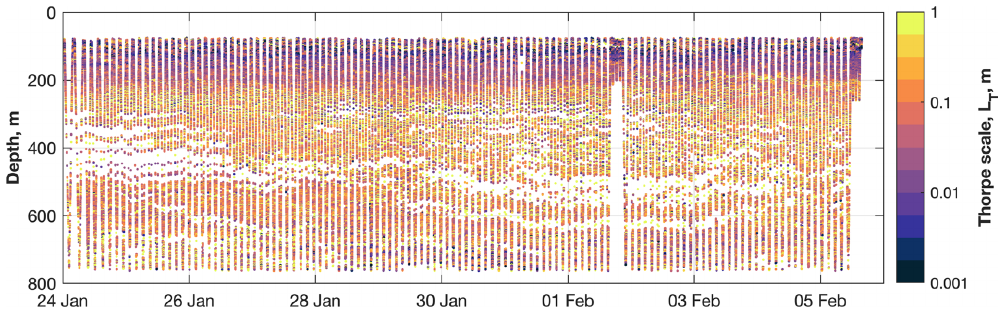
Figure 3. Thorpe scale estimates, L T (m). Higher values of L T are indicative of higher dissipation, ε T .